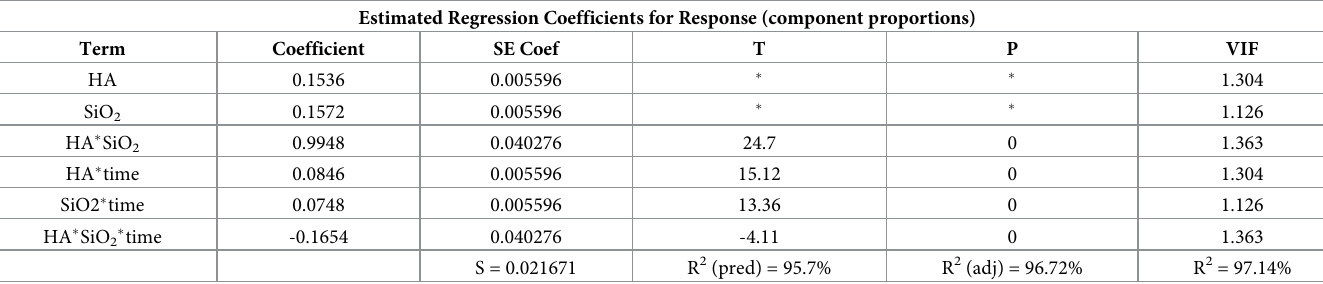
Table 2. Regression analysis for mixture process variable model of values at 48 h and 72 h. Estimated Regression Coefficients for Response (component